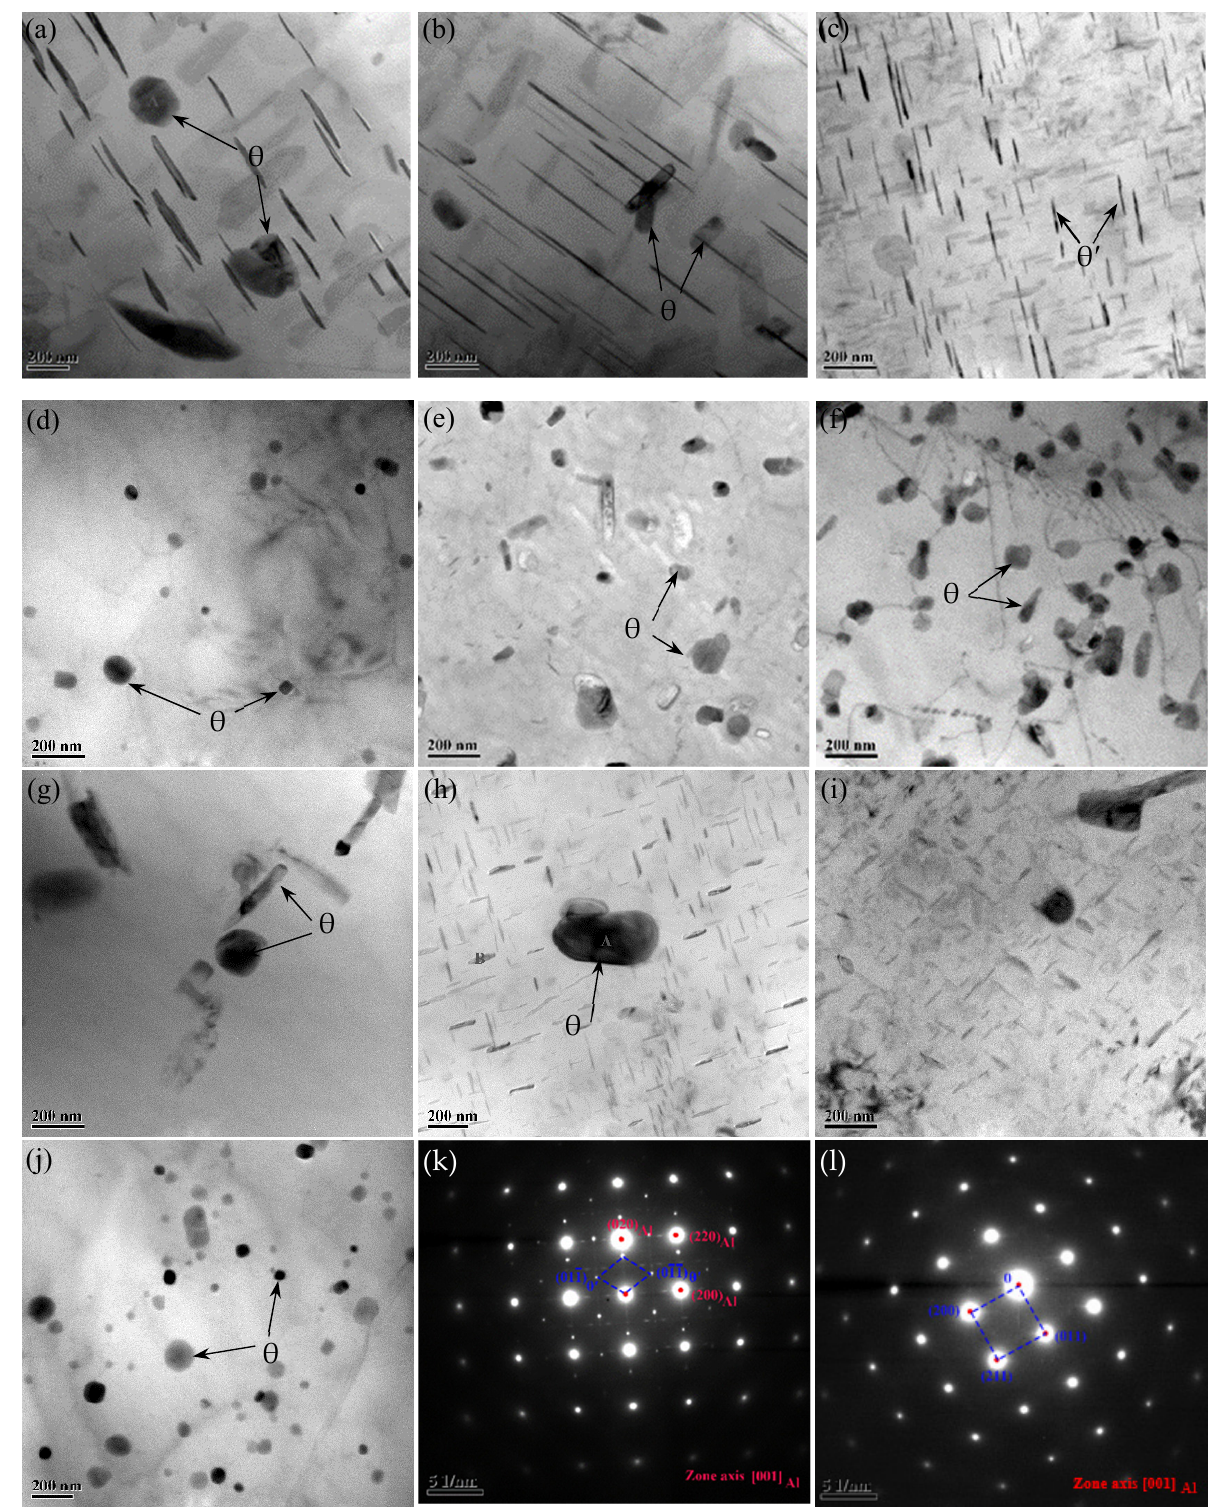
Figure 14. Morphology and distribution of the precipitates: ( a ) TMAZ, ( b ) HAZ, ( c ) BM, ( d ) NTMAZ, ( e ) NHAZ, ( f ) NZ, ( g ) PTMAZ, ( h ) plug center, ( i ) original plug, ( j ) RZ, and electron diffraction pattern of ( k ) θ ’ precipitates in BM, and ( l ) θ precipitates in HAZ. 3.4.4 EBSD analysis.